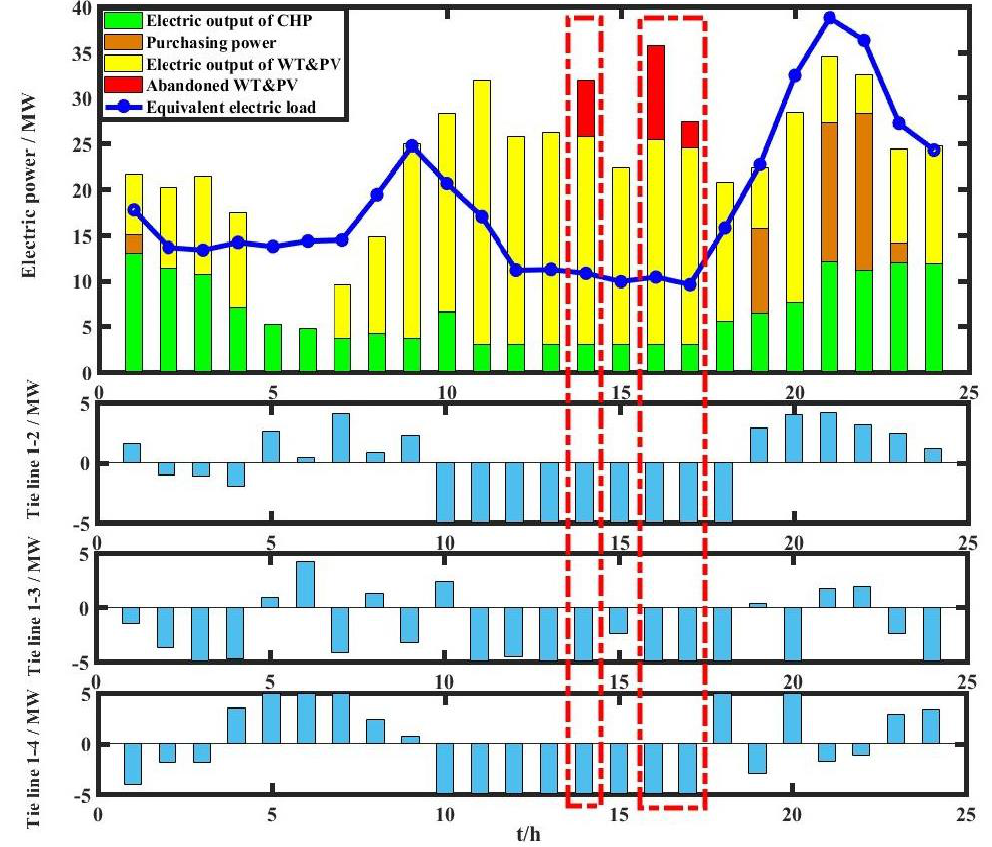
Figure 8. The optimization of electric power and tie line power in the residential area.